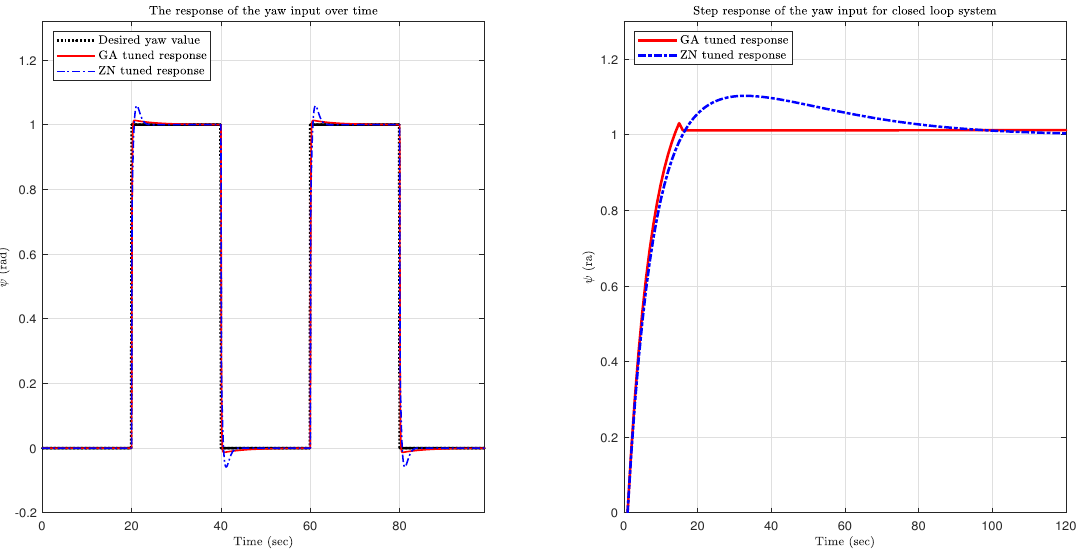
Figure 9. Simulated output responses of the yaw input of the quadcopter using GA and ZN